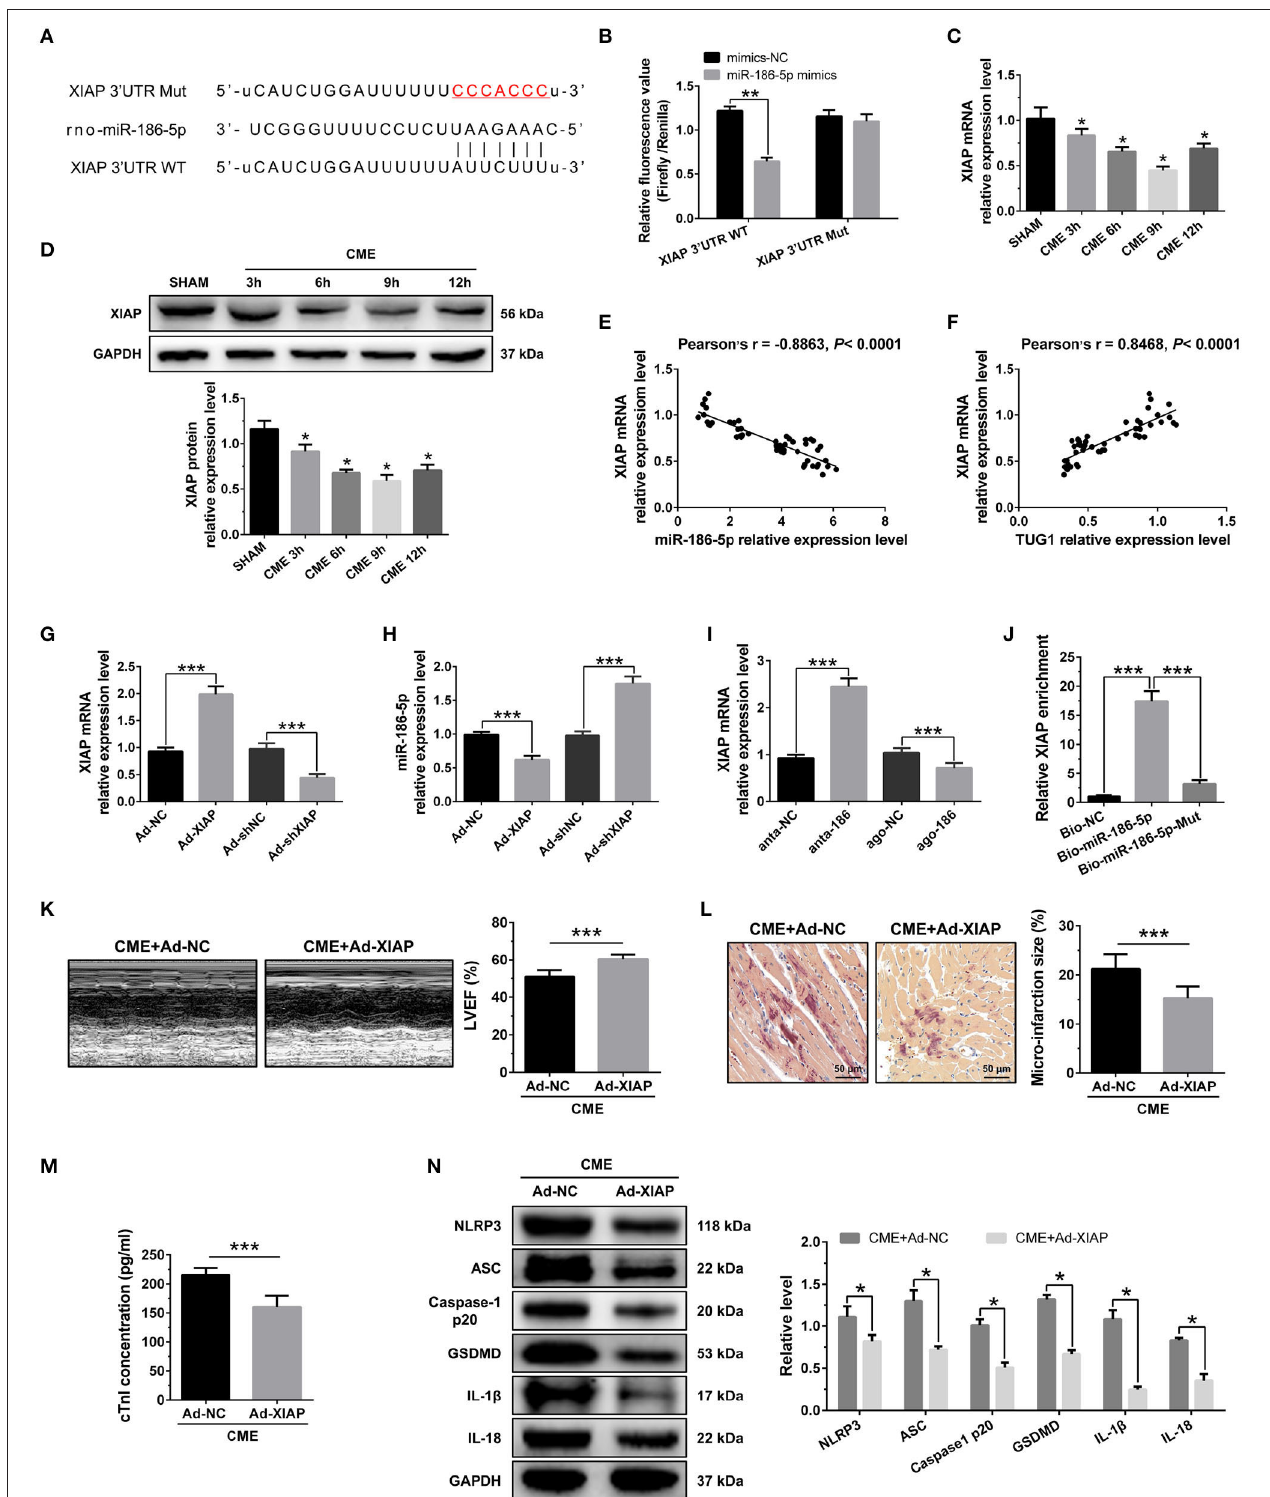
FIGURE 6 | XIAP is a direct target of miR-186-5p and regulates CME-induced myocardial injury. (A) The binding sites between miR-186-5p and XIAP were predicted by using bioinformatics analysis. (B) Relative luciferase activity in WT-XIAP and MUT-XIAP. (C) Myocardial XIAP mRNA levels were assessed via qRT-PCR ( n =